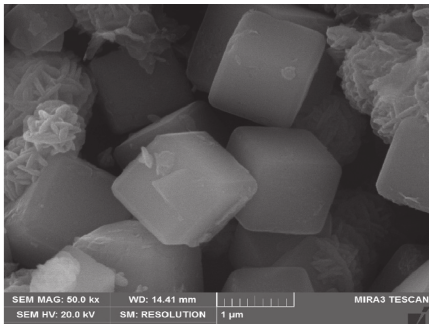
Figure 2: FE-SEM images of